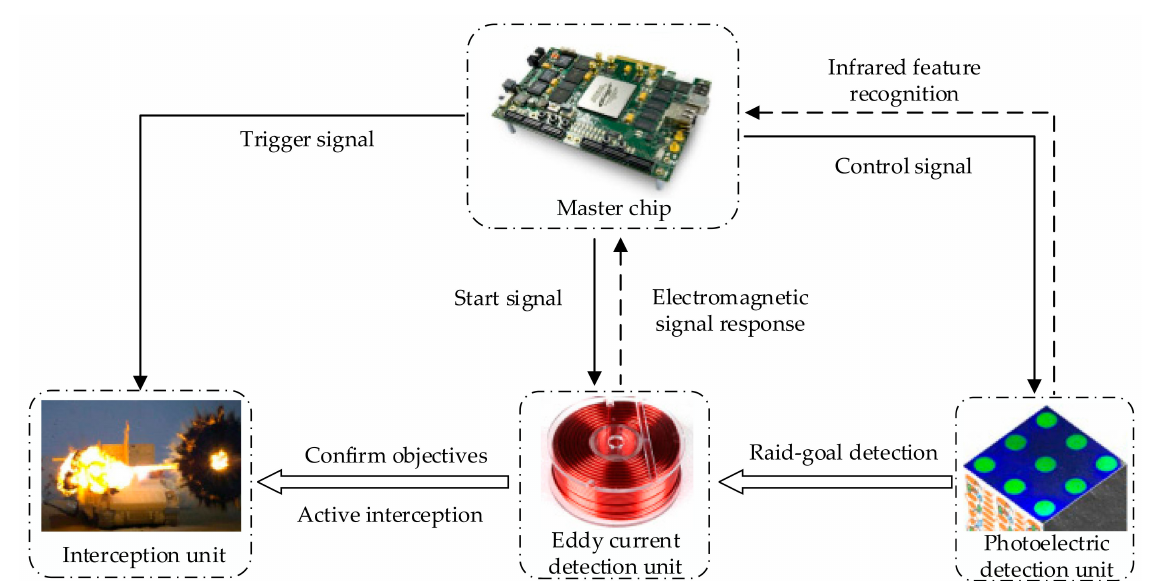
Figure 2. Detection system workflow